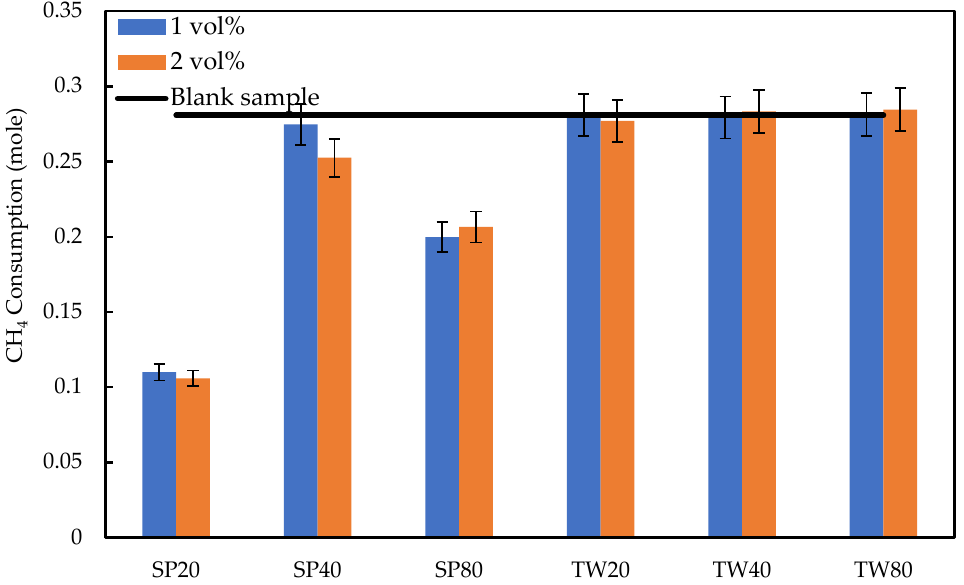
Figure 8. The effect of non-ionic surfactant on the degree of CH 4 consumption. (Oil/H 2 O: 50/50; 277 K, 85 bar).